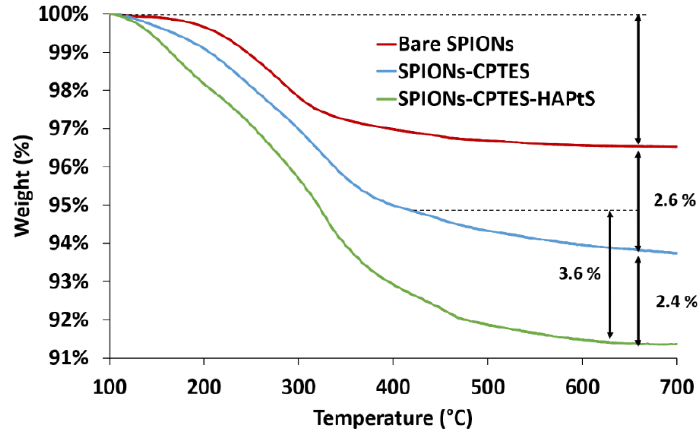
Figure 9. Thermogravimetric analysis (TGA) curves of bare and grafted SPIONs under air (100–700°C). Table 5 . Thermogravimetric data and calculation of the number of molecules on SPIONs’ surface.